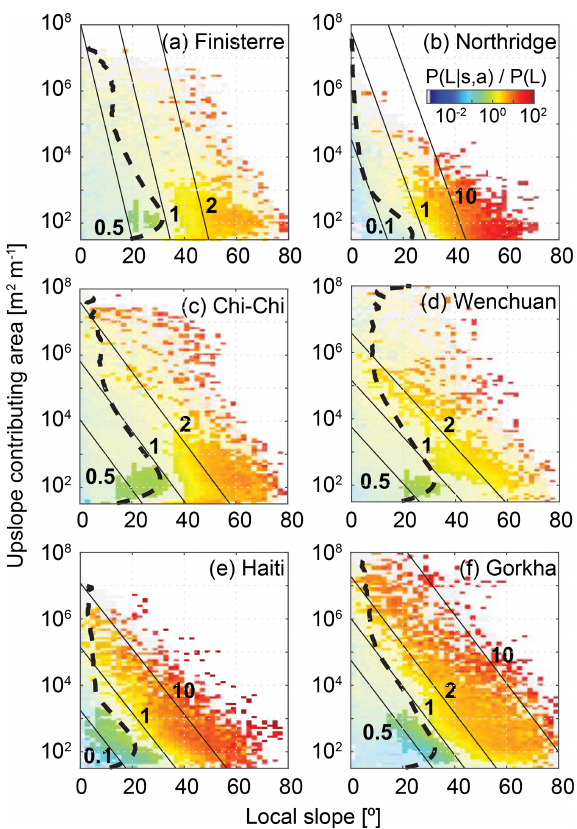
Figure 4. Two-dimensional plots of landslide hazard defined as con- ditional landslide probability P(L | s,a) normalised by study area average landslide probability P(L) , where s is local slope and a is upslope contributing area per unit cell width. Dashed lines show the mean slope per upslope contributing area bin, using 100 logarith- mically spaced bins. Solid lines are landslide probability contours derived from logistic regression in the same units as the conditional landslide probability surface. Grey cells indicate slope–area pairs with data but with no cells touching a landslide. Note that upslope contributing area is shown on a logarithmic axis, so that maintain- ing a constant landslide probability for a given increase in slope re- quires a larger reduction in upslope contributing area at low slopes than at high slopes. Fainter colours indicate landslide hazard esti- mates that do not differ significantly from the study area average at 90%